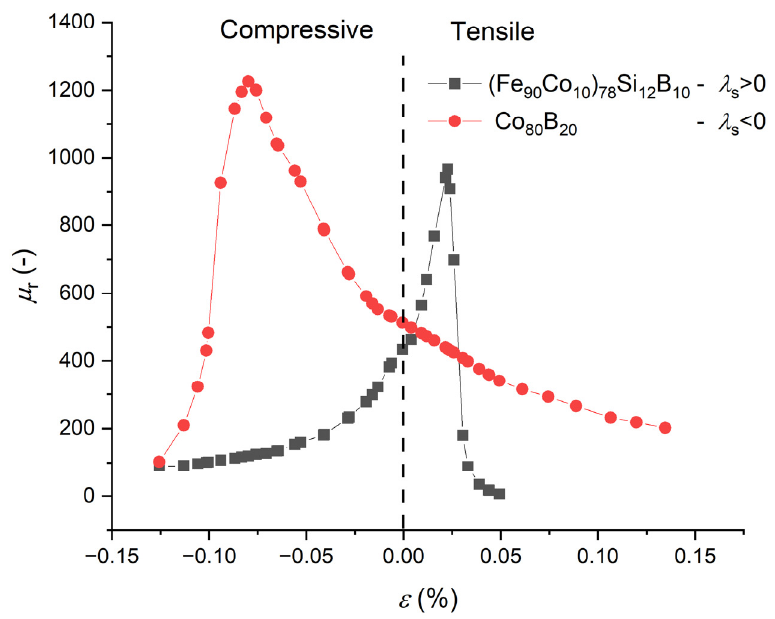
Figure 8. Permeability ( µ r ~ χ ) versus strain ( ε = E σ , with E the material Young’s modulus of the materials) for a Fe-based material with positive λ s and a Co-based material with negative λ s